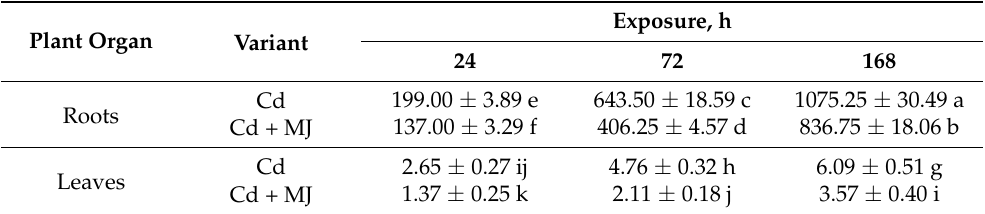
Table 1. Effect of MJ on Cd content ( µ g/g dry weight) in roots and shoots of wheat seedlings. Plant